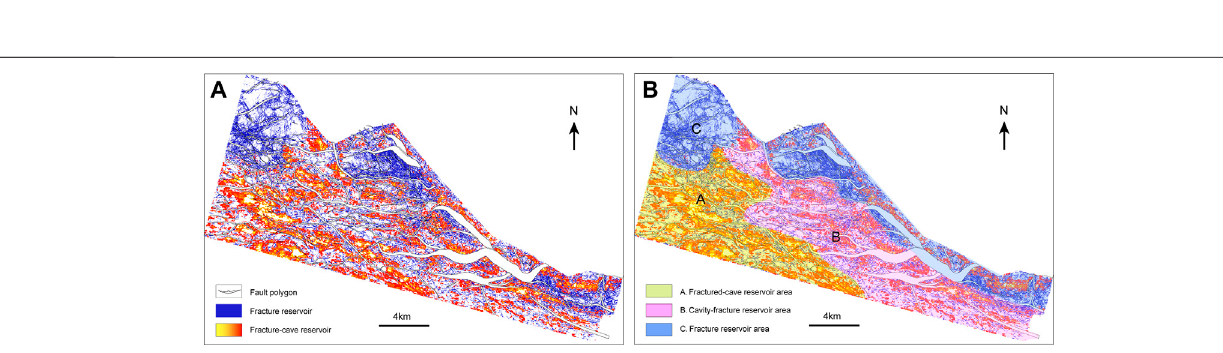
Frontiers in Earth Science |